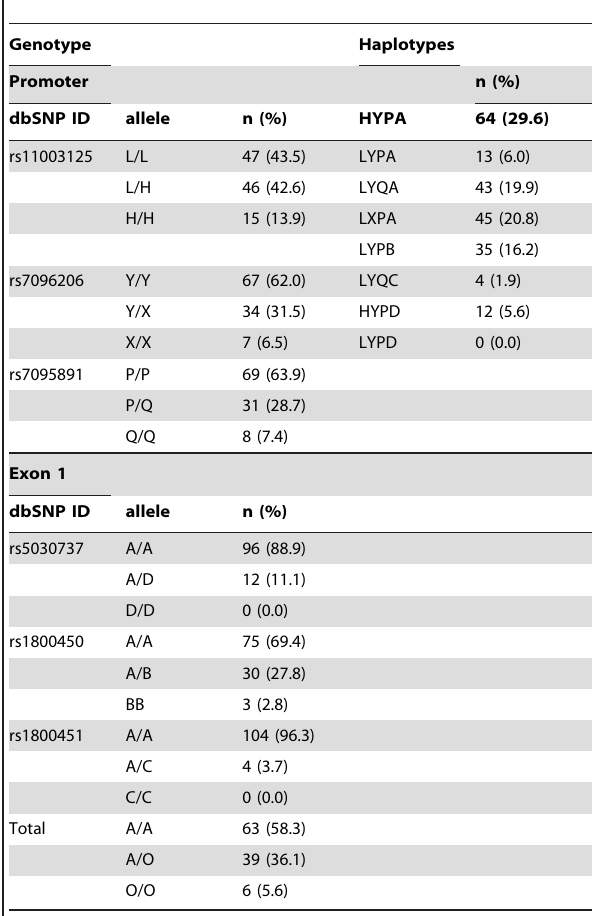
Table 3. MBL2 genotype frequencies observed in this cohort (n=108).